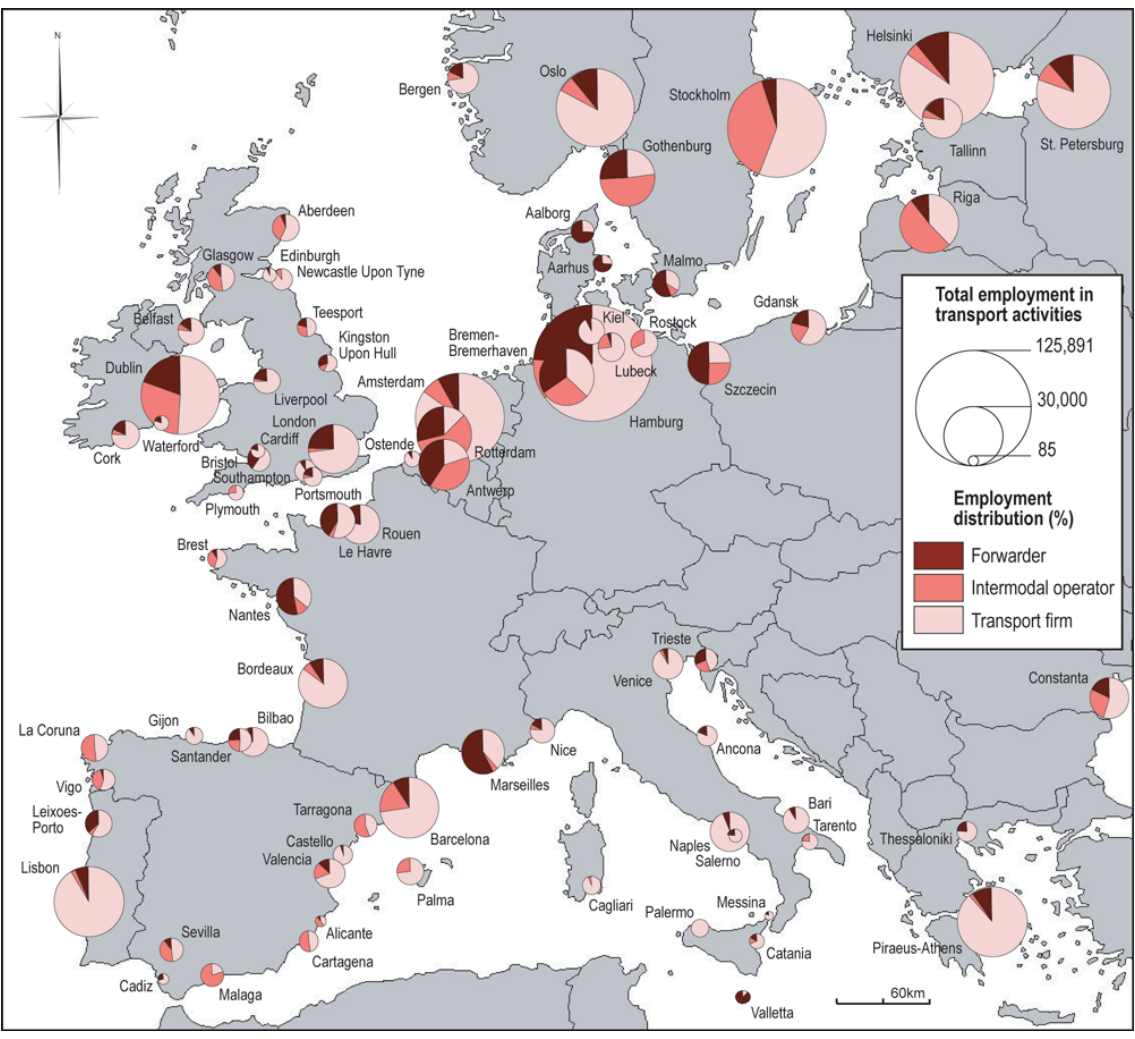
Figure 4. Distribution of employment by types of firms at European